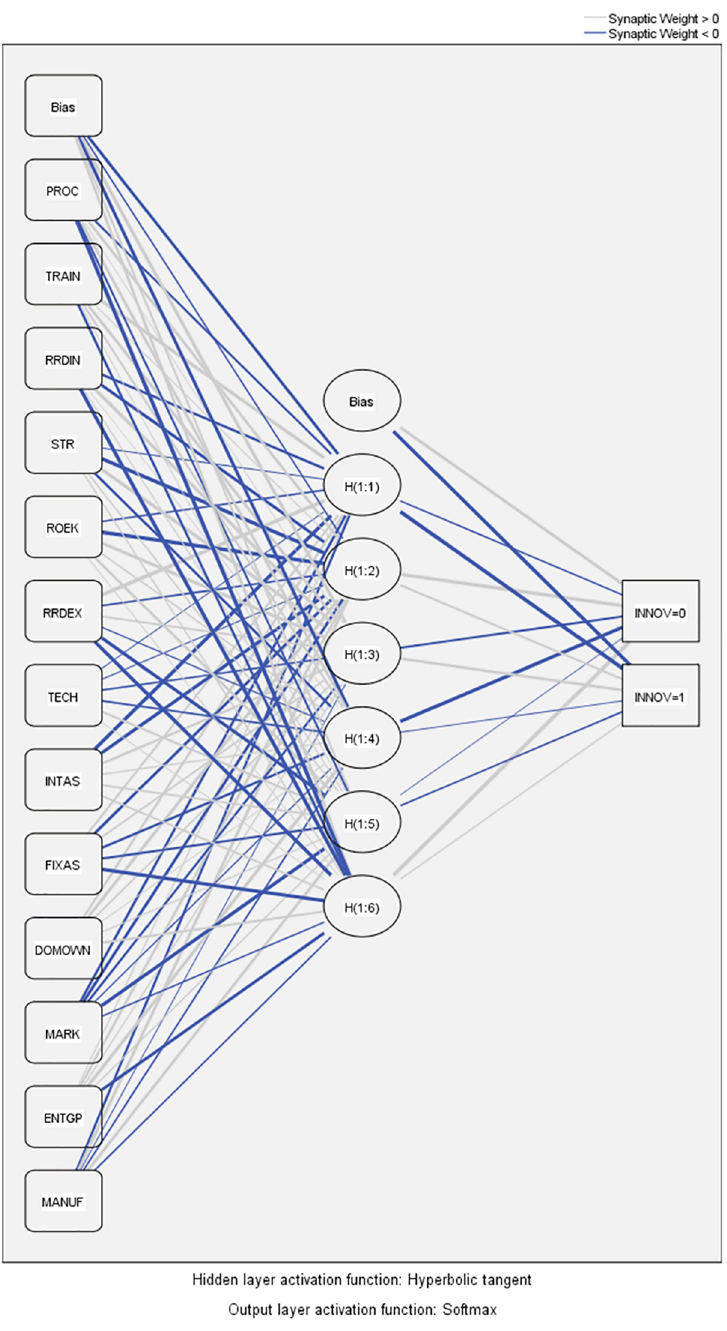
Fig 3. Artificial neural network diagram–Model